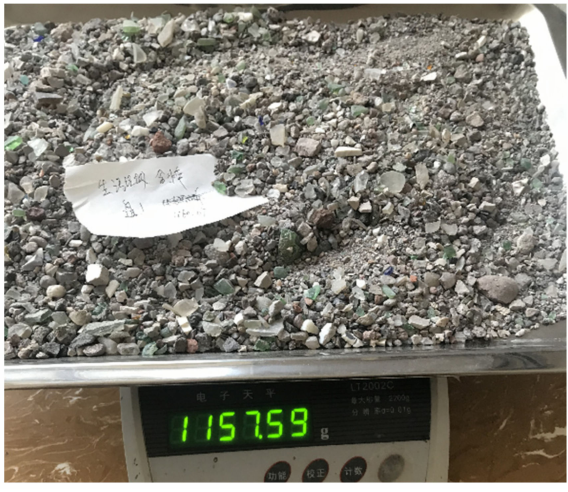
Figure 1. MSWI BA